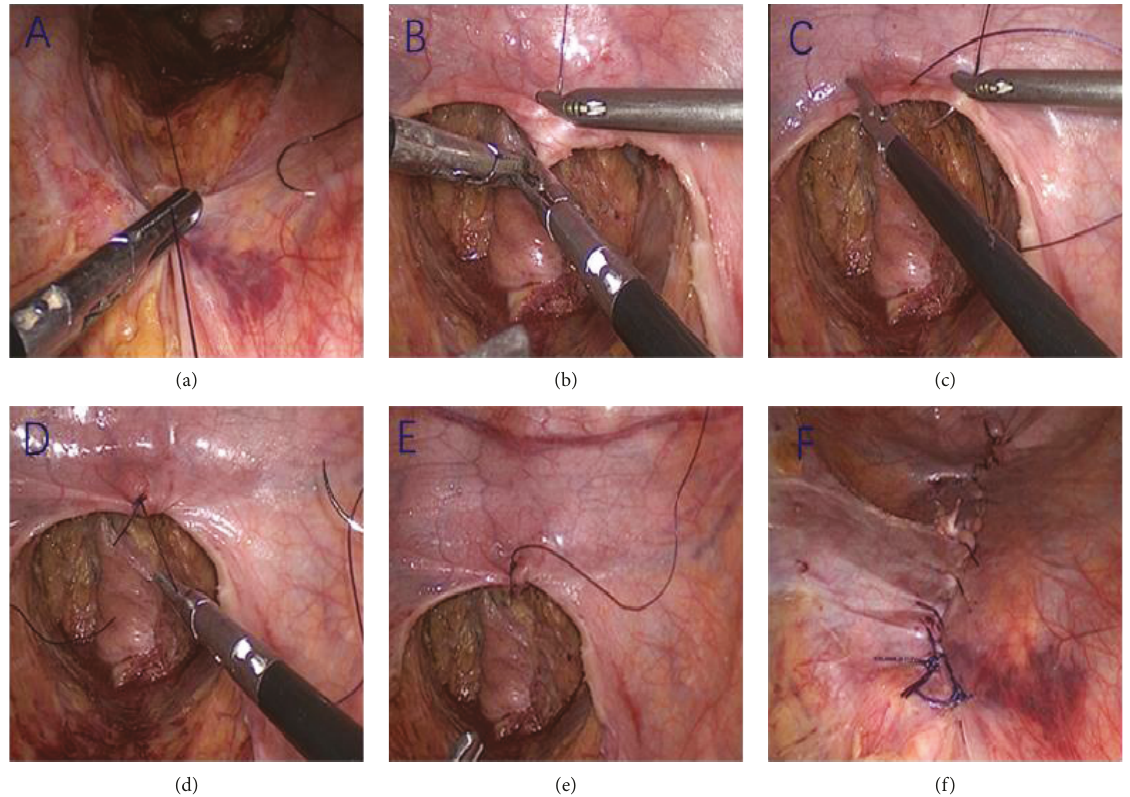
Figure 1: (a) The fi rst square knot which needed force and care. (b – e) The second fi gure-of-eight suture. (f) The continuous suture was then performed to close the